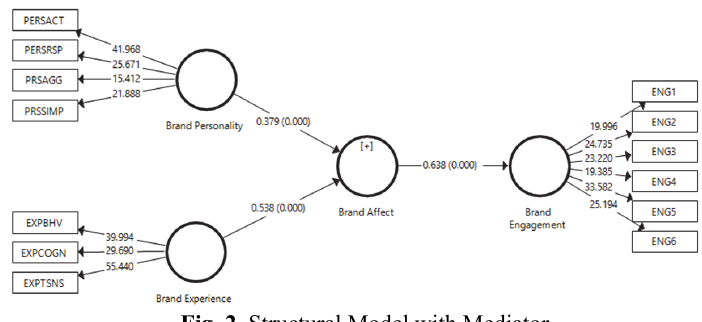
Fig. 2. Structural Model with